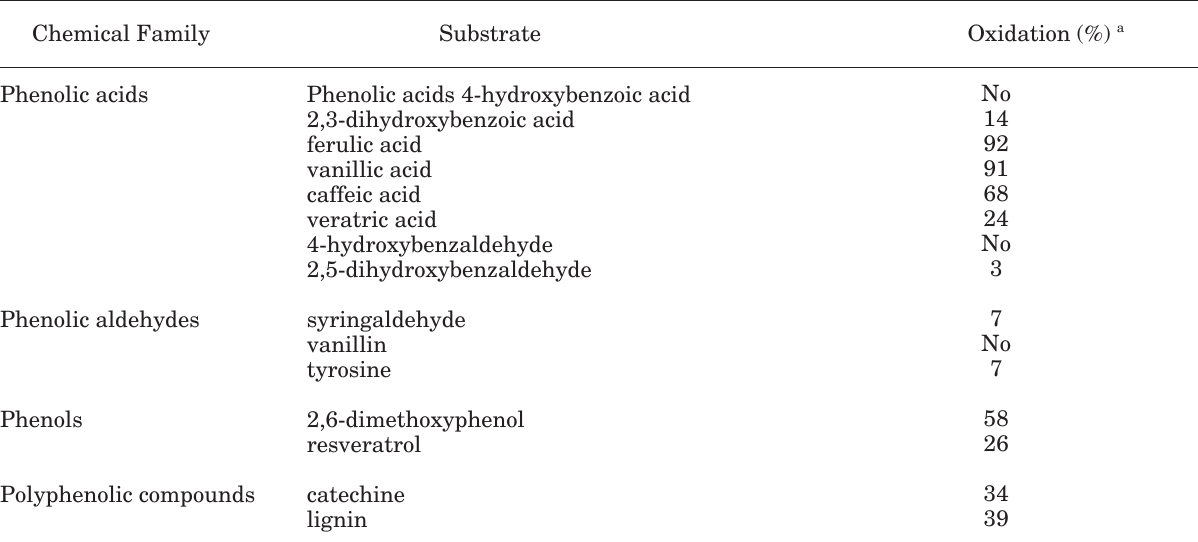
Table 2. Substrate specificity of purified laccase from Fomitiporia mediterranea. Chemical